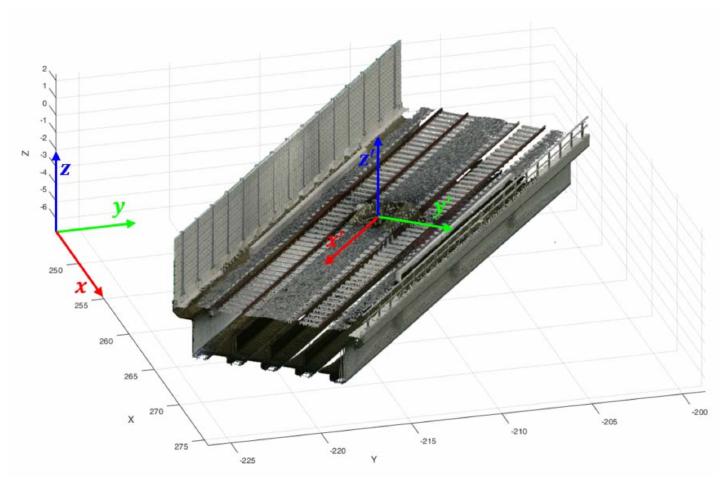
Figure 3. Measurement coordinate system (x-y-z) and bridge coordinate system (x’-y’-z’).